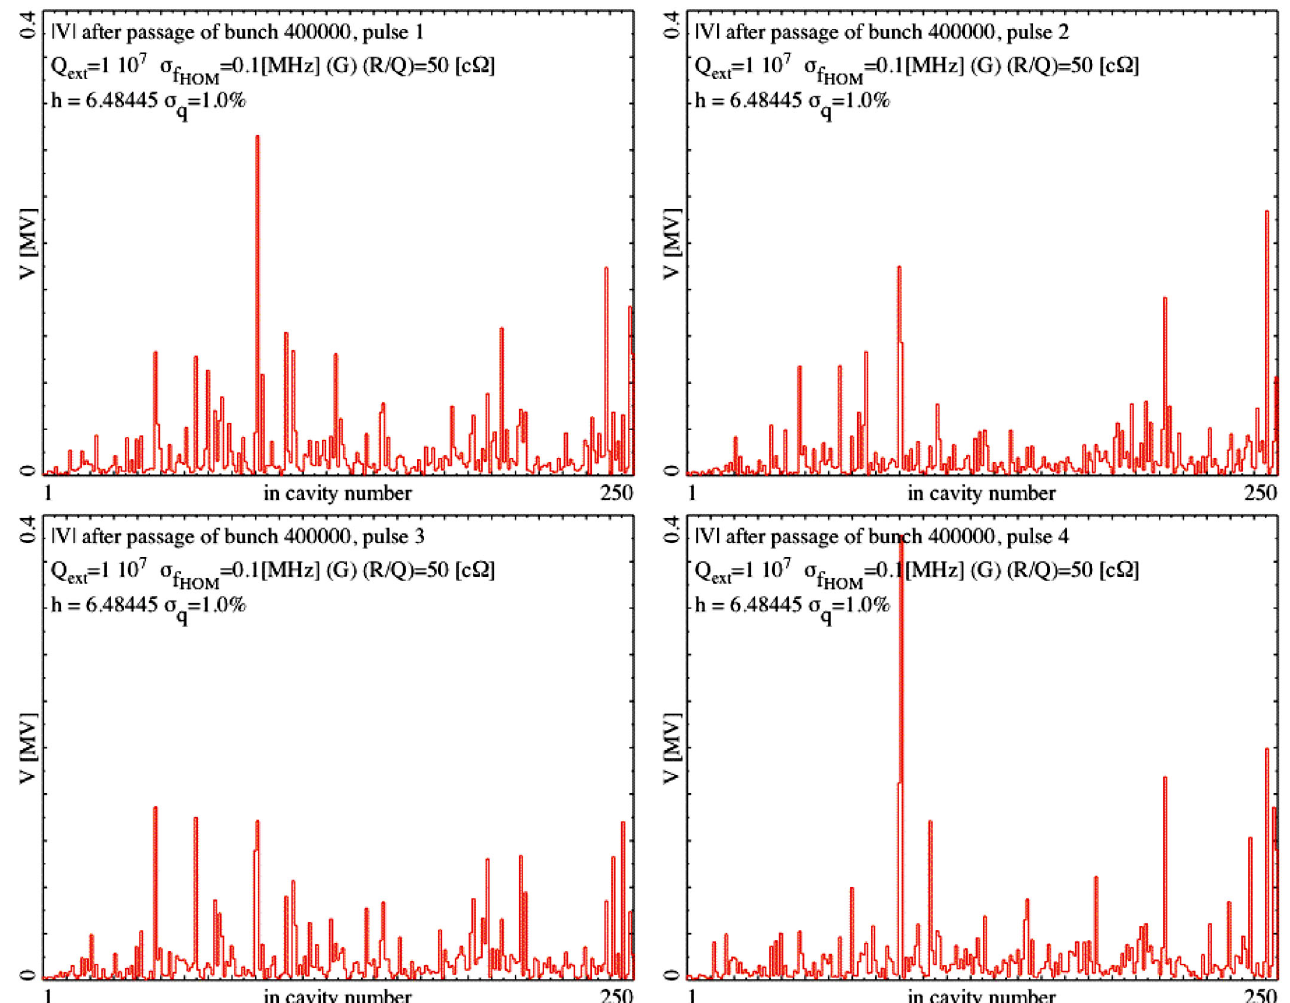
FIG. 14. (Color) Cavity voltage plots after four different pulses corresponding to Fig. 13. Cavity #91 is clearly the worst one for pulses 1 and 4 but not for pulses 2 and